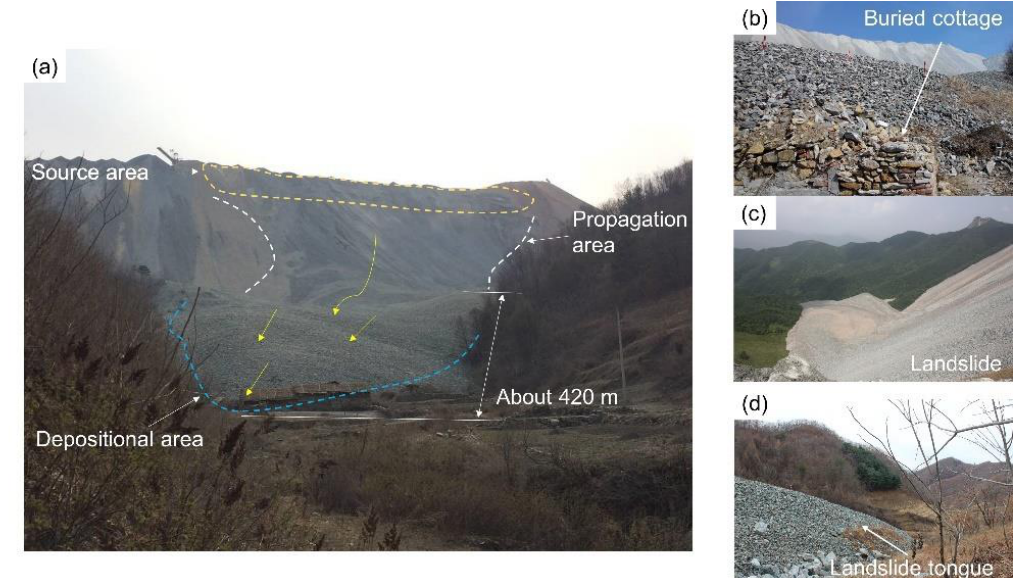
Figure 5. The landslides of the full high waste dump: ( a ) landslides’ topography; ( b ) buried cottage; ( c ) landslides in top view; ( d ) landslides’ tongue.